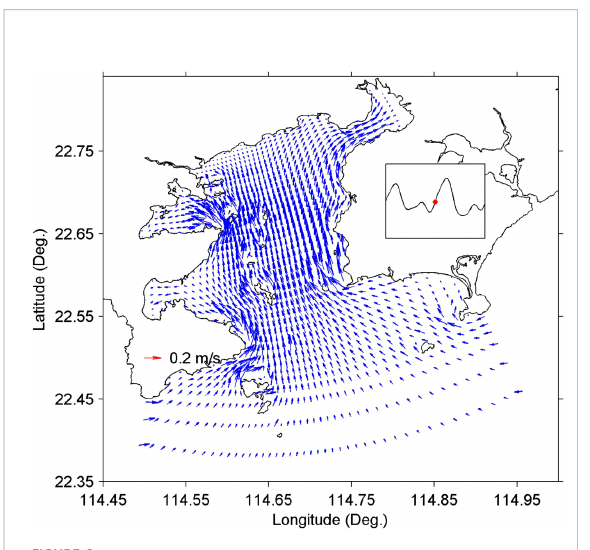
FIGURE 6 Simulated surface tidal currents during fl ood tide period in the Daya Bay.